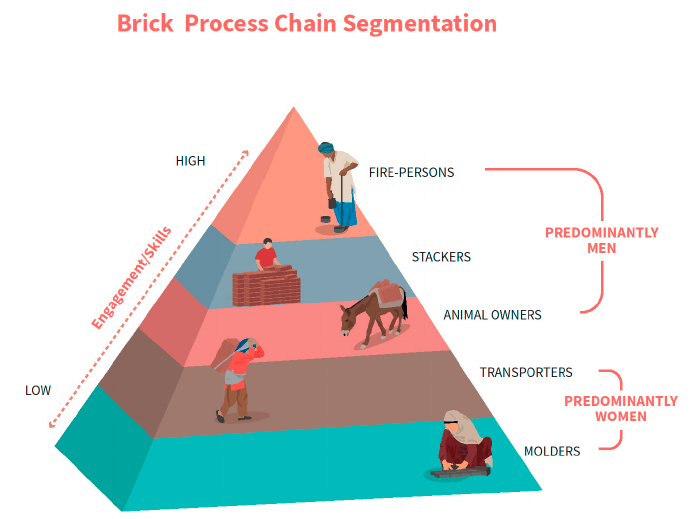
Figure 2. Brick process chain